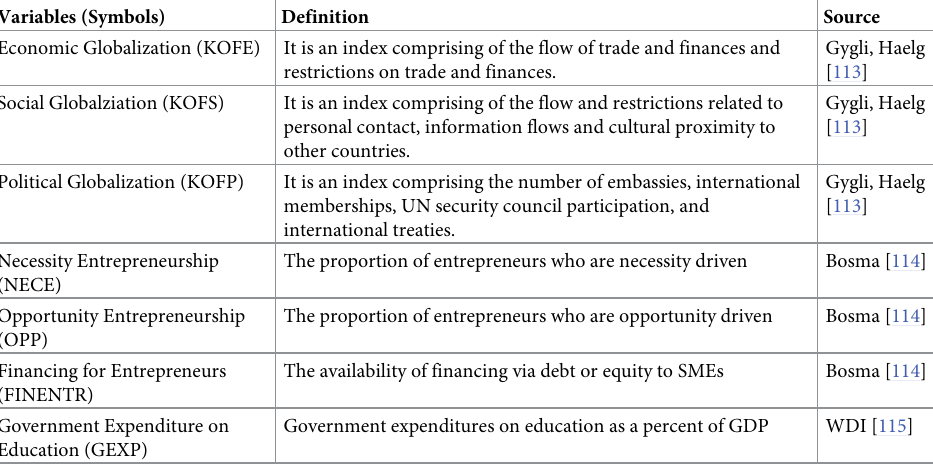
Table 1. Construction of